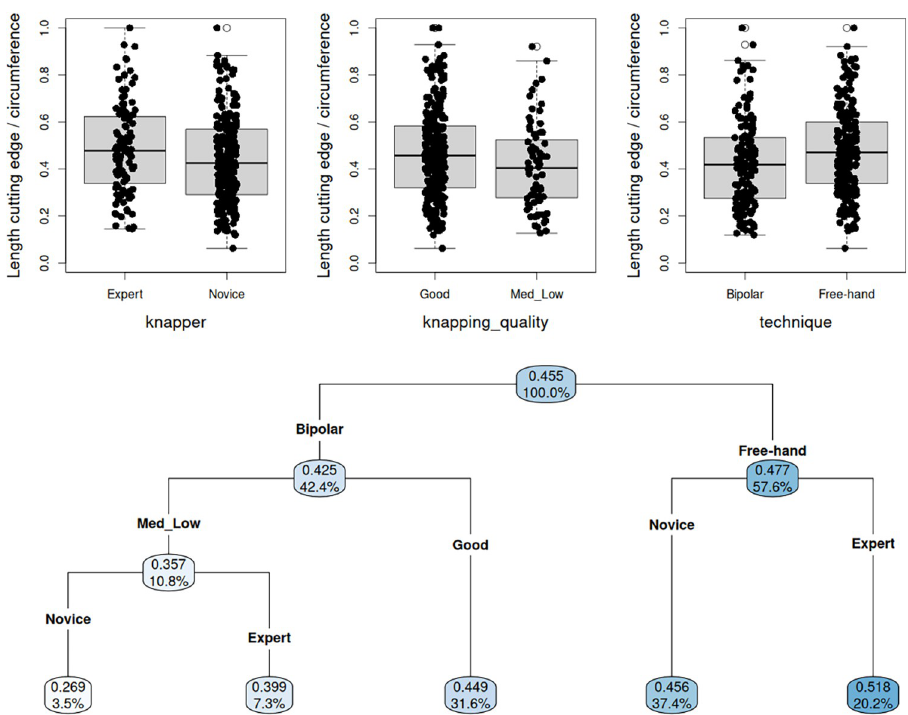
Fig 6. a. Boxplots and stripcharts for the impact of each factor on the extension of cutting edge; b. Regression tree for the extension of cutting edges, with knapping technique, raw material quality and knapping expertise as covariates. (In each node, the upper value is the empirical proportion observed for a given combination of experimental conditions; the "%" value indicates the percentage of the total sample size in this node).